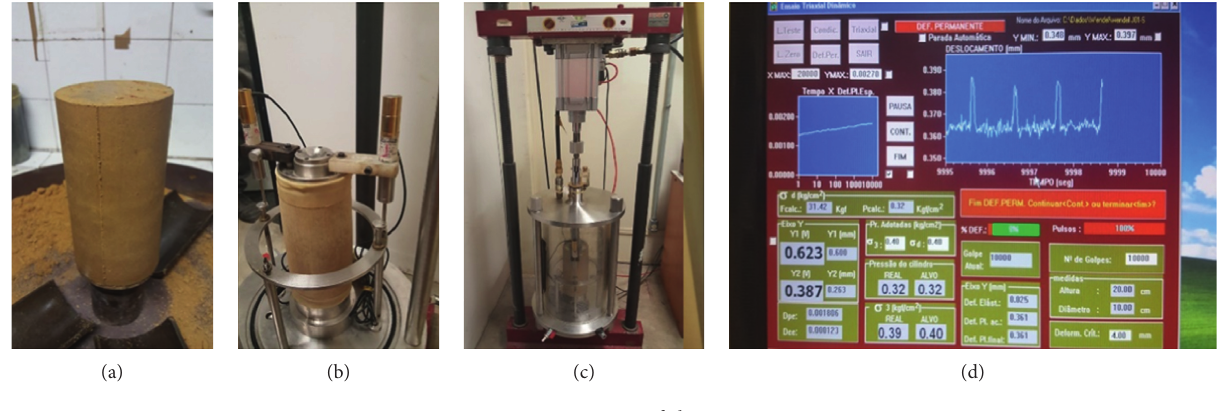
Figure 2: Stages of the test. Table 4: Evaluated models of the tested materials.